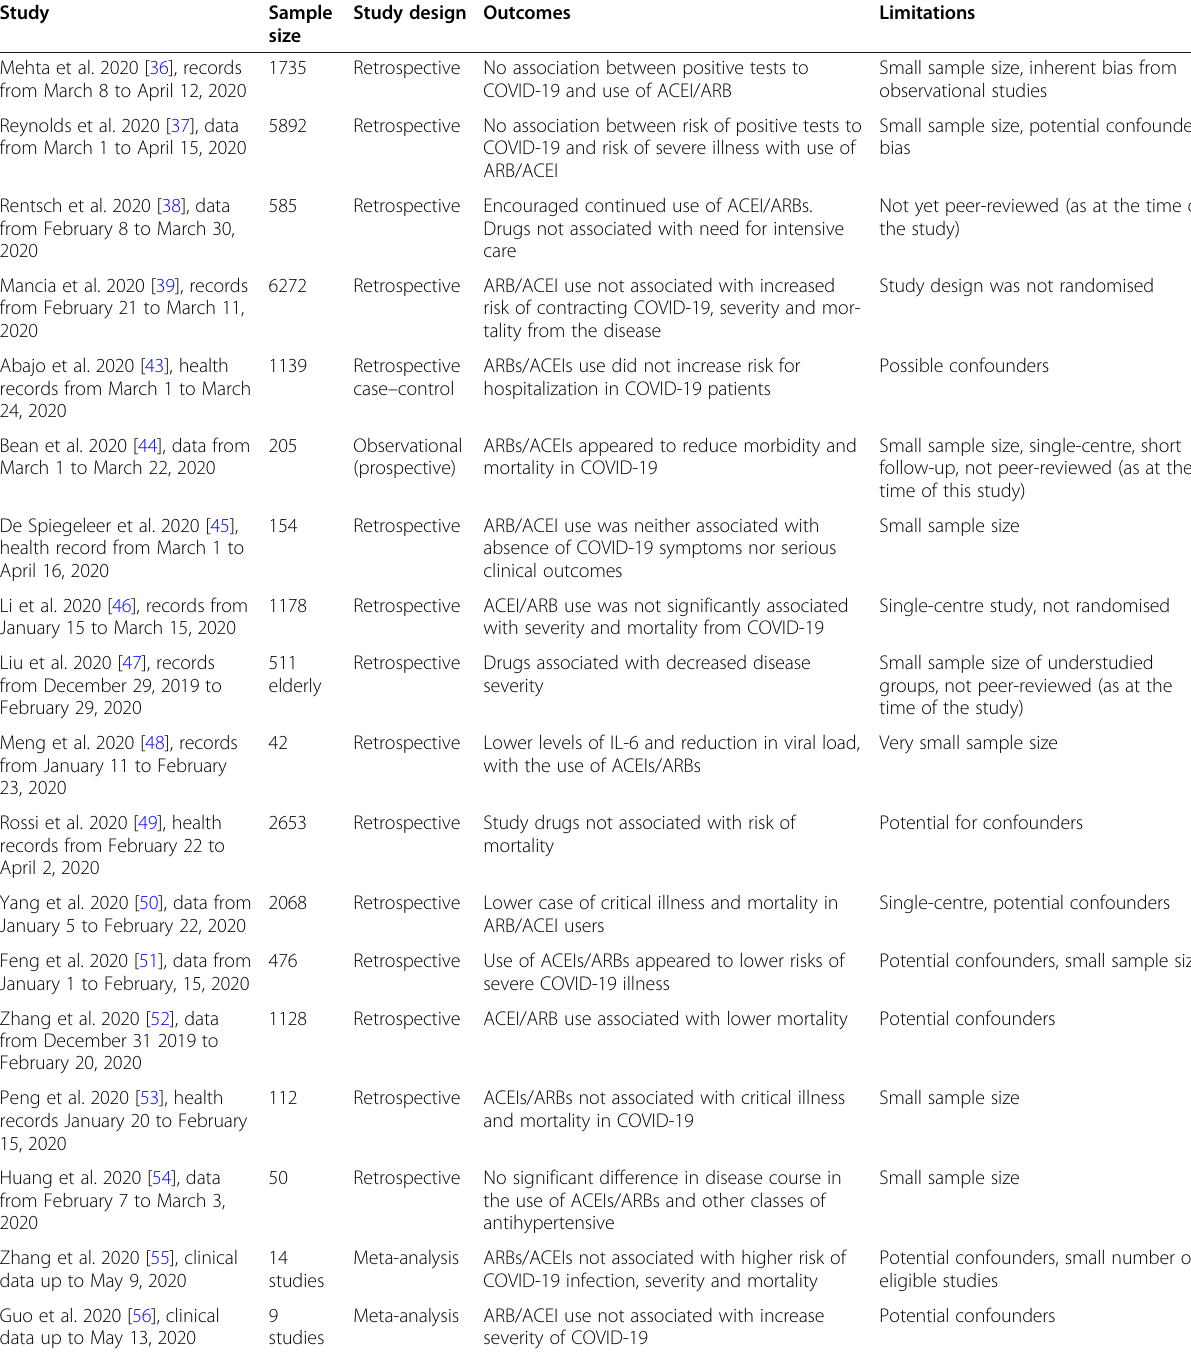
Table 1 Characteristics of the studies